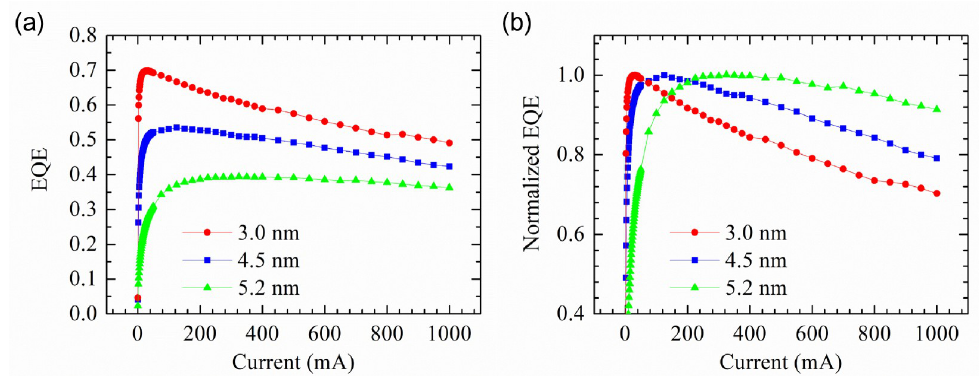
Figure 3. ( a ) The measured absolute and ( b ) Normalized external quantum efficiency (EQE) of the LEDs with different LQWs of 3.0 nm, 4.5 nm and 5.2 nm.